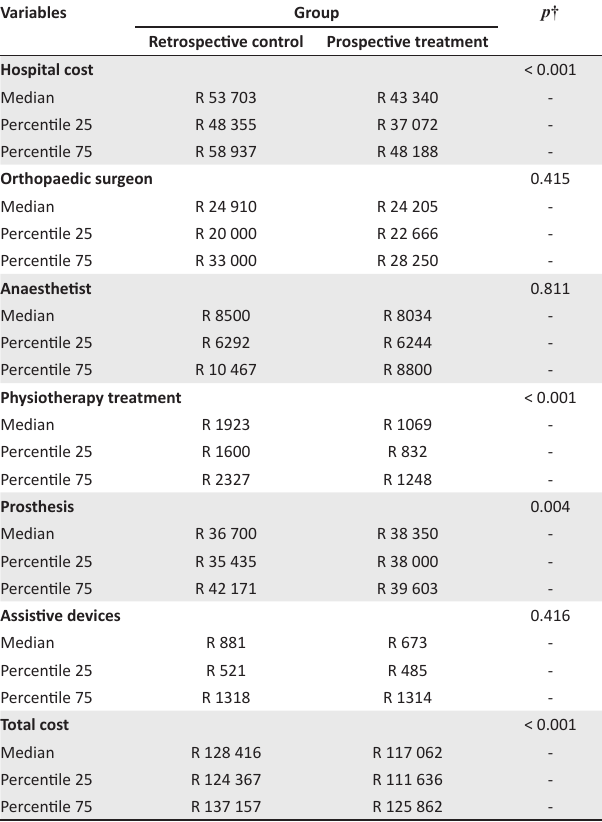
TABLE 6: Simple in-hospital cost comparison between groups (median and inter-quartile range). Variables Group p † Retrospective control Prospective